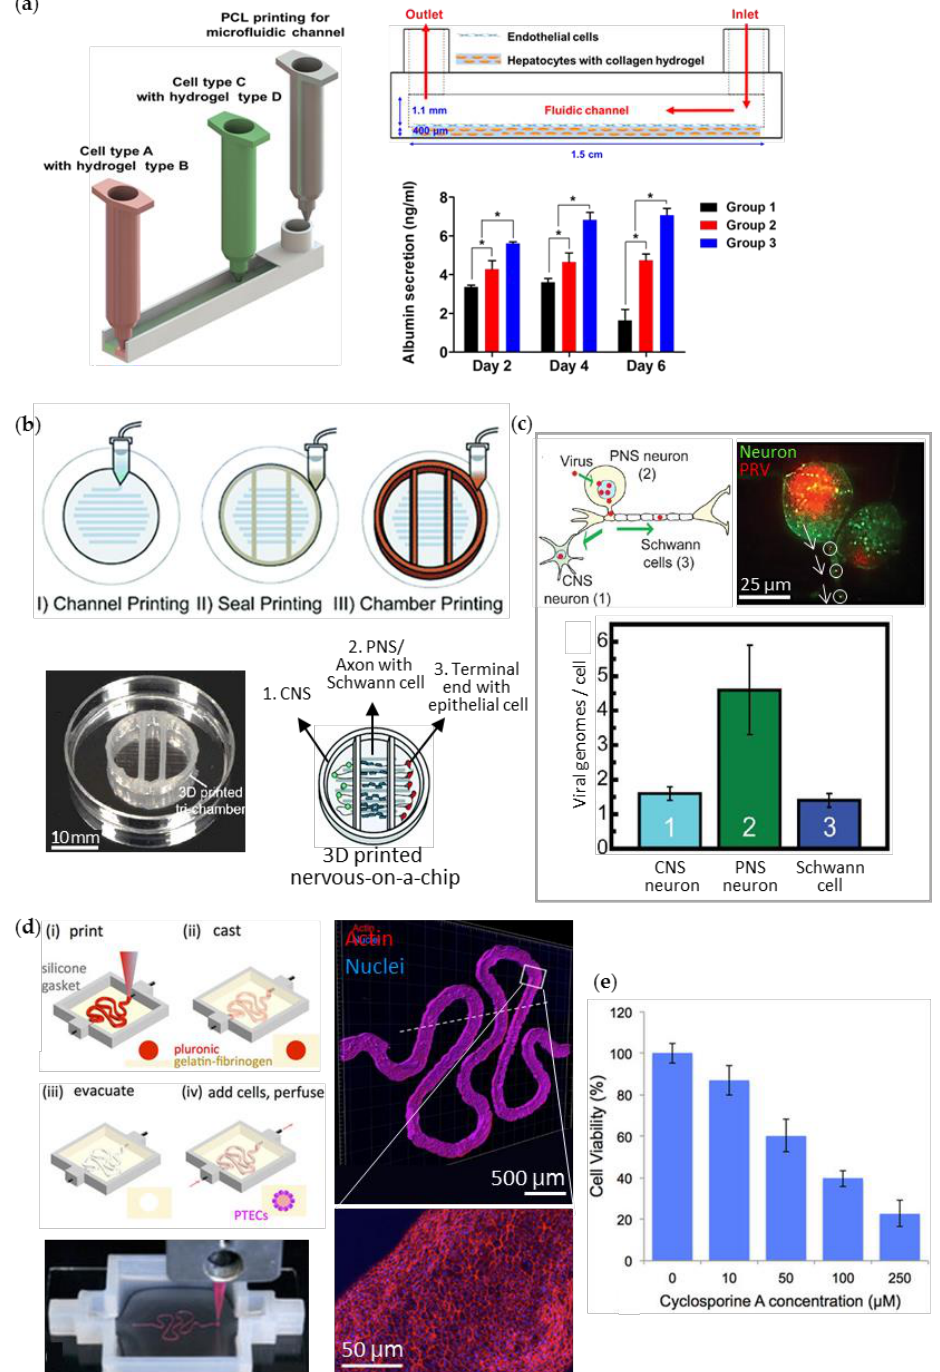
Figure 6. 3D-printed organs-on-chips in a one-step fabrication process. ( a ) Schematic diagrams for extrusion printing of liver-on-a-chip resembling sinusoid (Group 1 = 3D cell-printed hepatocytes alone in static culture, Group 2 = 3D cell-printed hepatocytes–endothelial cells in static culture, and Group 3 = 3D cell-printed liver-on-a-chip); ( b ) Extrusion-printed nervous system-on-a-chip with compartmentalized chambers: central neurons (CNS) in chamber 1, peripheral neurons (PNS), and the axons with Schwann cells in chamber 2, and terminal cell junctions with epithelial cells in chamber 3; ( c ) Study of viral infection in the neuron system. Microscopic observation of the pseudorabies virus (PRV) transmission and the level of the transported virus in each chamber; ( d ) Illustration (upper left) and photograph (lower left) of the extrusion-printing process of a kidney proximal tubule-on-a-chip and the immunofluorescent stained images of the tubule (upper and lower right); ( e ) Nephrotoxicity effect of cyclosporine A on kidney epithelial cells in the chip. Reproduced with permissions from [50,87,88].